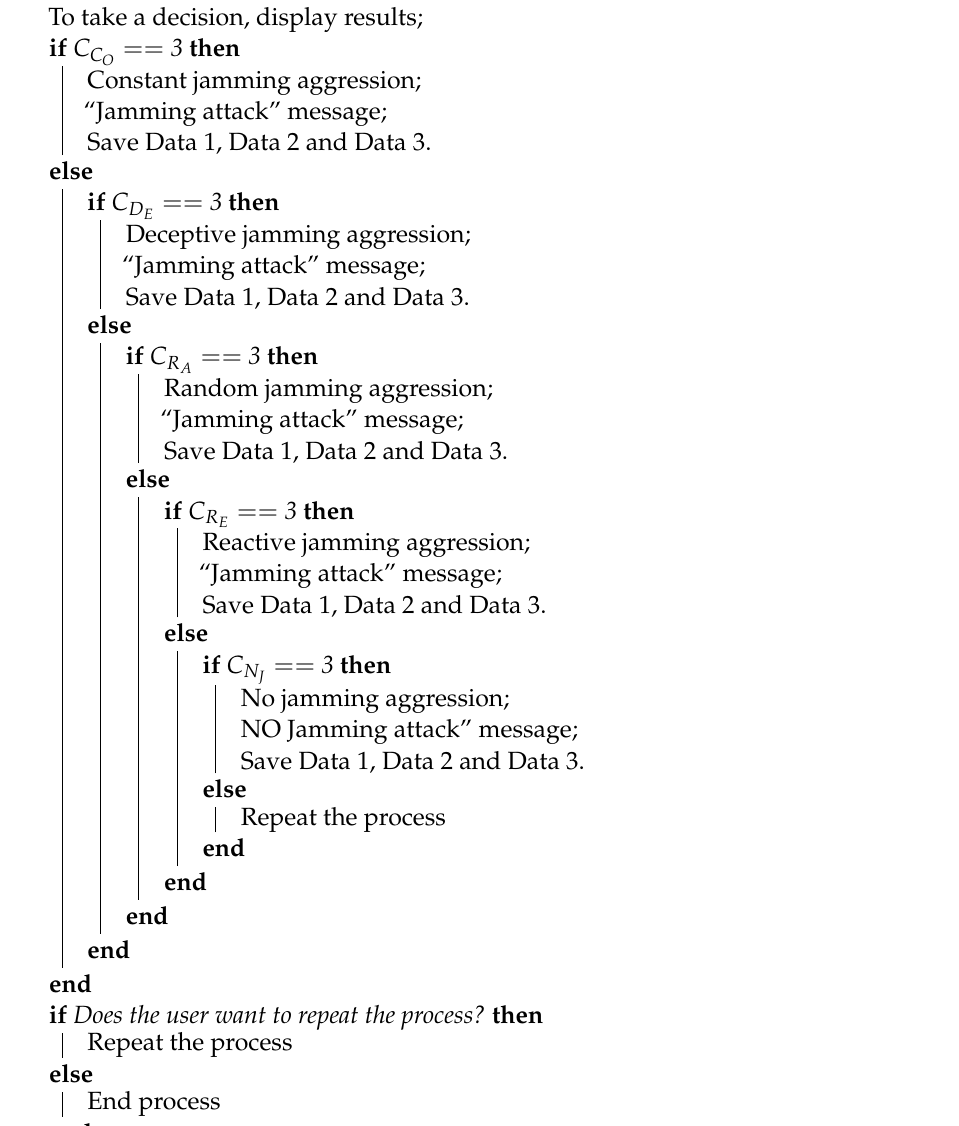
Algorithm 4: Proposed jamming detection algorithm for collaborative and coop- erative WSN. Part